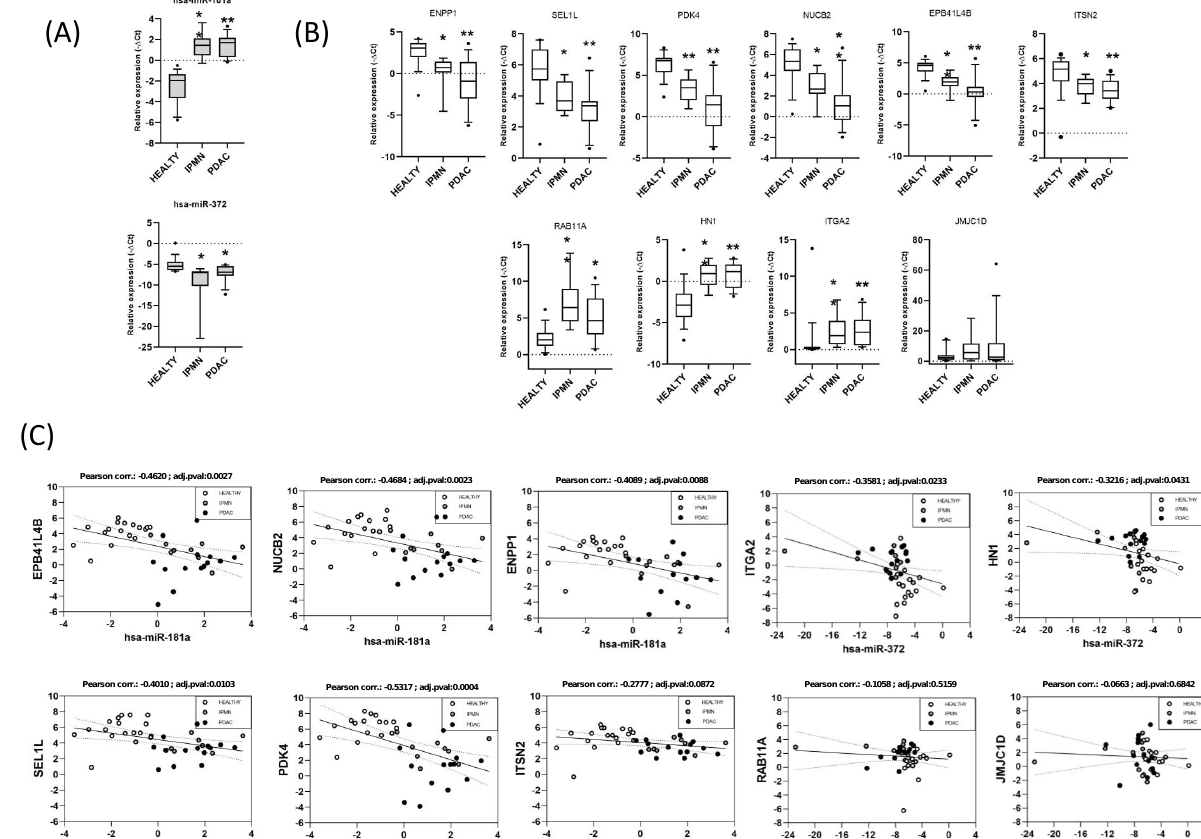
Figure 5. qRT-PCR expression analysis of selected miRNA-mRNA pairs in pancreatic patient samples. ( A ) Boxplots for miRNA expression (miR-181a and miR-372) in Healthy ( n = 17), IPMN ( n = 9) and PDAC ( n = 14) pancreatic samples, samples with deviation from the mean >5% are represented as black dots. ( B ) Boxplots for mRNA expression of selected potential targets related with metabolic alterations (NUC2B, SEL1L, ENPP1, PDK4 and JMJD1C, RAB11A) and with cytoskeletal-related pathways (EPB41L4B, ITSN2 and ITGA2, HN1), respectively, in Healthy ( n = 17), IPMN ( n = 9) and PDAC ( n = 14) pancreatic samples, samples with deviation from the mean >5% are represented as black dots ( C ) Correlation plots of miRNA versus mRNA expression values measured by qRT-PCR ( − ∆ Ct). * p value < 0.05 ** p value <